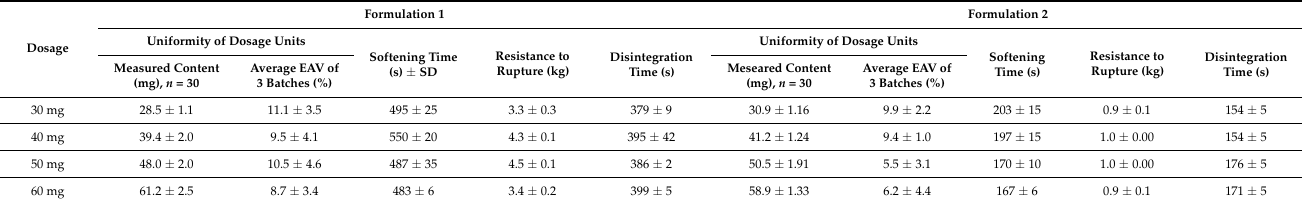
Table 3. Initial characterisation of formulations F1 and F2. Values expressed as the mean ± SD (standard deviation), with n = 3, except if stated otherwise); EAV = experimental acceptance value.